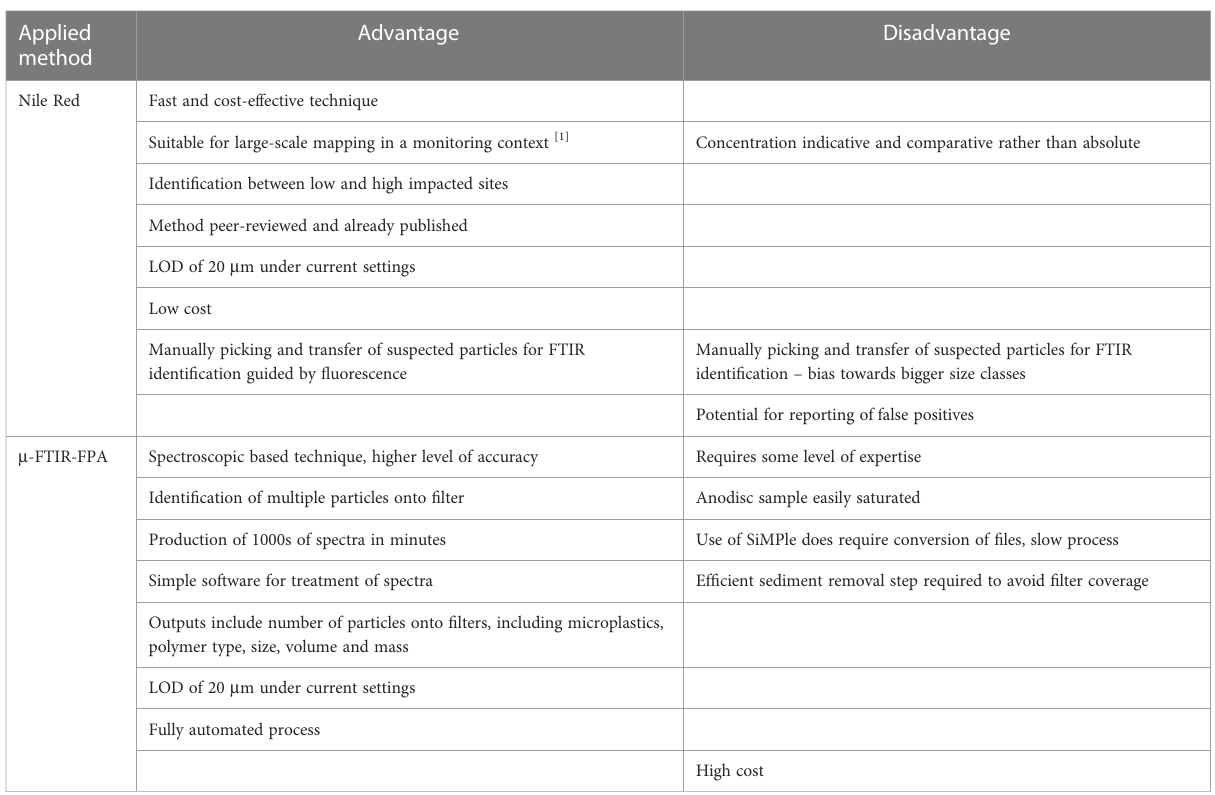
TABLE 2 Advantages and disadvantages of the use of the NR and m -FTIR-FPA methods for the monitoring of microplastics in sediment samples. Applied